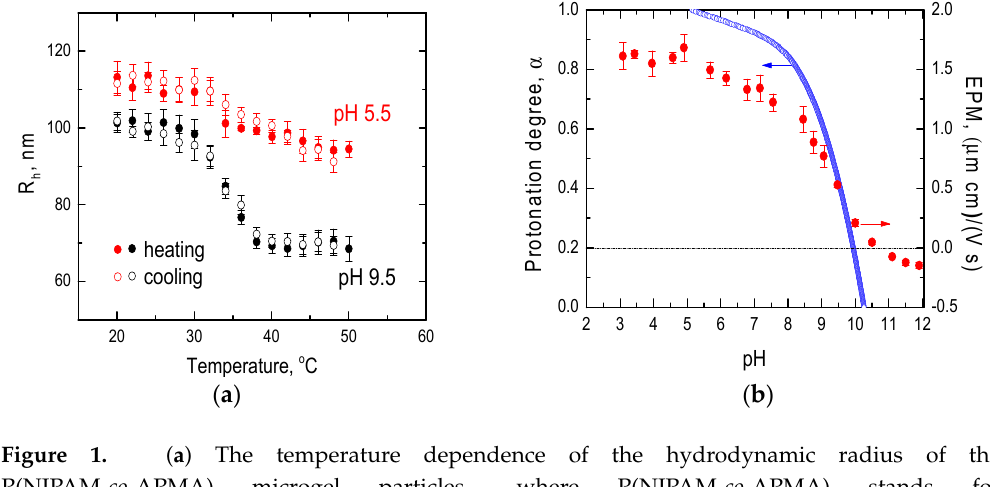
Figure 1. ( a ) The temperature dependence of the hydrodynamic radius of the P(NIPAM- co -APMA) ( a ) The temperature dependence of the hydrodynamic radius of the microgel particles, where P(NIPAM- co -APMA) stands for poly( N -isopropylacrylamide- co - N -(3- P(NIPAM- co -APMA) microgel particles, where P(NIPAM- co -APMA) stands for aminopropyl)methacrylamide), at pH 5.5 ( α ≅ 1.0) and pH 9.5 ( α ≅ 0.45). ( b ) The pH-dependence of poly( N -isopropylacrylamide- co - N -(3-aminopropyl)methacrylamide), at pH 5.5 ( α ∼ = 1.0) and the protonation degree α of the P(NIPAM- co -APMA) microgel obtained from the potentiometric pH 9.5 ( α ∼ = 0.45). ( b ) The pH-dependence of the protonation degree α of the P(NIPAM- co -APMA) titration data (blue circles) and the electrophoretic mobility (EPM) values of the microgel particles at microgel obtained from the potentiometric titration data (blue circles) and the electrophoretic different pH-values obtained at 25 °C by laser microelectrophoresis (red circles). mobility (EPM) values of the microgel particles at different pH-values obtained at 25 ◦ C by laser microelectrophoresis (red